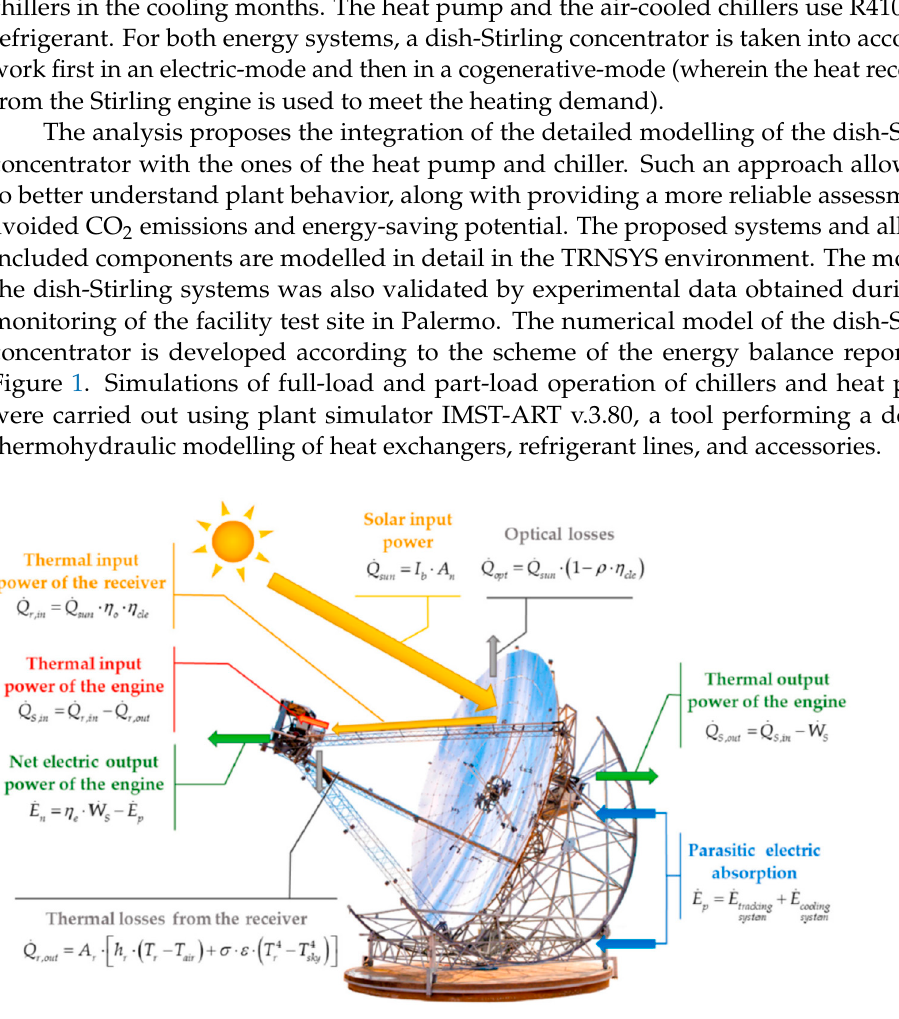
Figure 1 . Scheme of the energy balance of the dish ‐ Stirling concentrator [15]